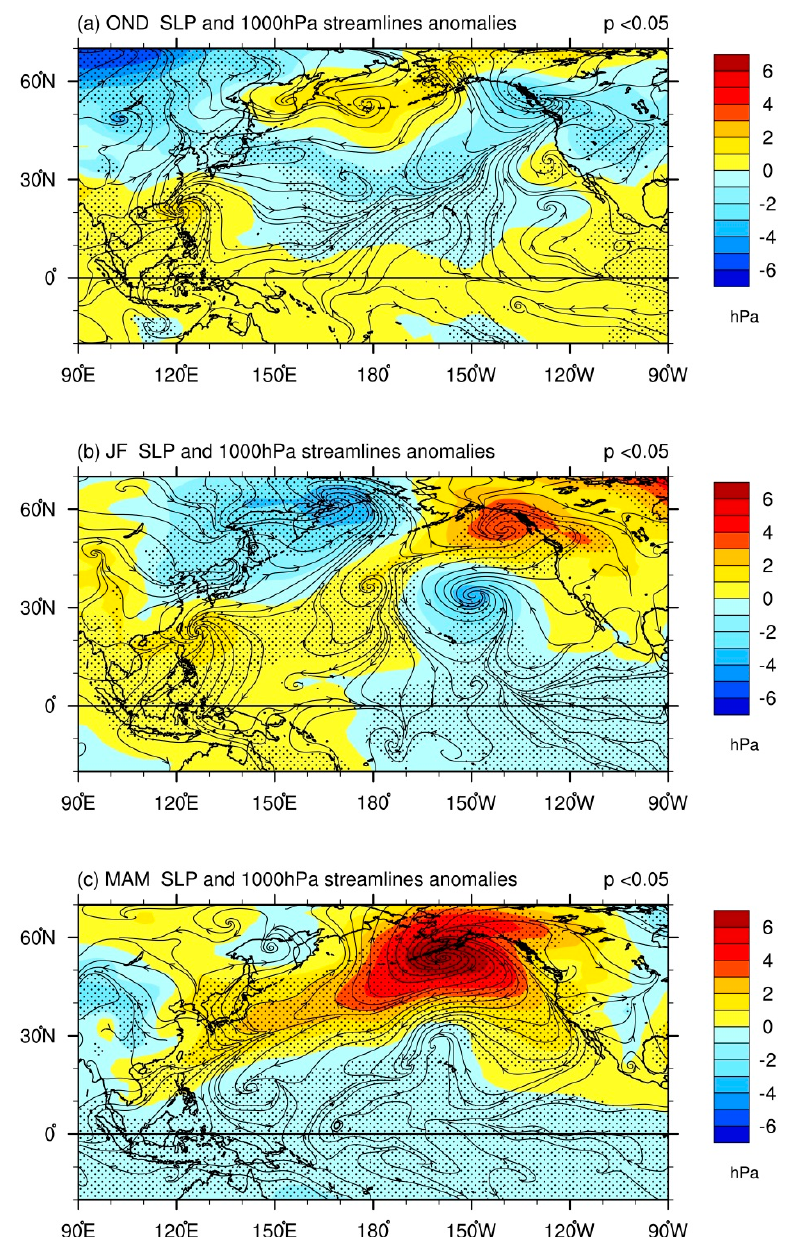
Figure 6. Same as Figure 5, but for anomalous SLP (colored shading; unit: hPa) and 1000 hPa circulations (streamlines) during ( a ) OND, ( b ) JF, and ( c ) MAM. The dots denote areas passing 95% confidence level.